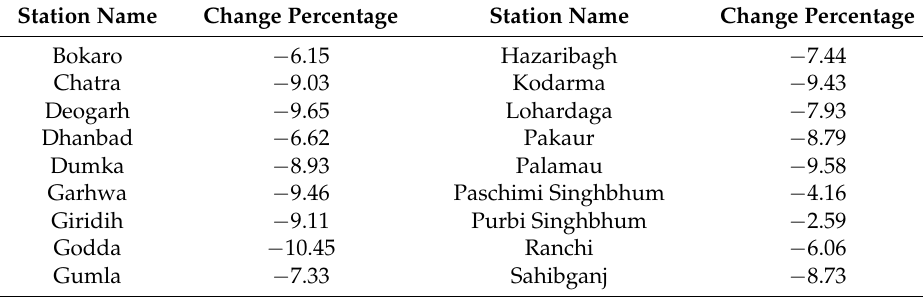
Table 6. Percentage change in the mean of 1901–1951 over the mean of 1952–2002.